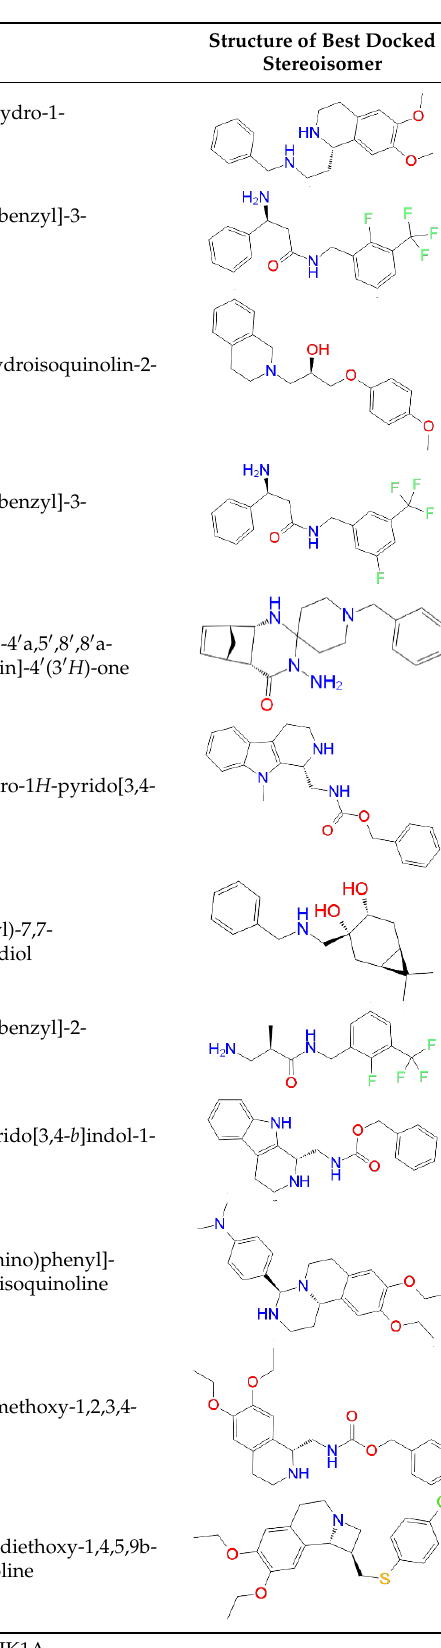
Table 3. Sigma-1 receptor binding parameters for racemic ligands in guinea pig liver membrane homogenates and the corresponding docking scores. Measured ID Docking K i (nM)